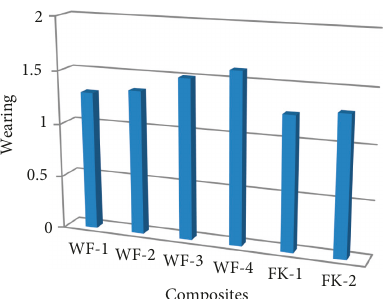
Figure 8: Wear and coefficient of friction behaviour of developed